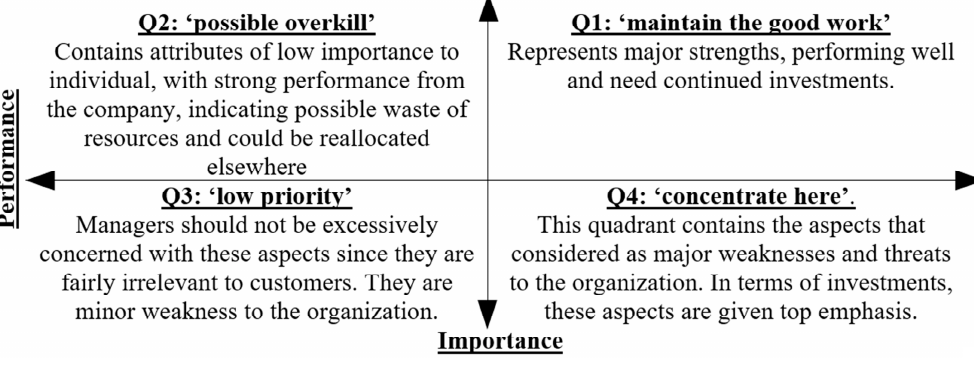
Table 3. Demographic information of the workers.